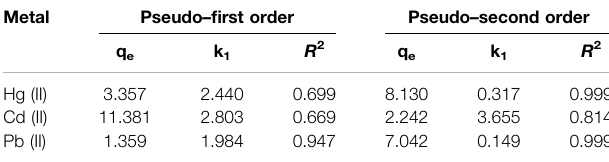
TABLE 2 | Constant kinetics of pseudo – fi rst- and pseudo – second-order models for Hg (II), Cd (II), and Pb (II) adsorption in Penicillium sp . mold